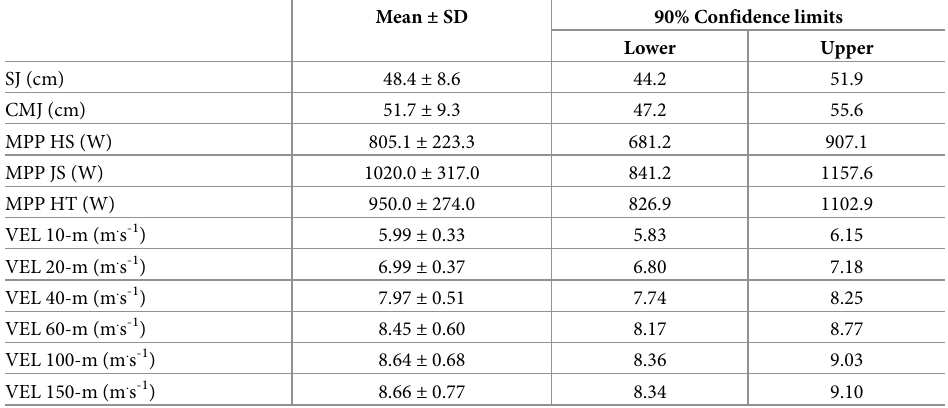
Table 1. Mean ± standard deviation (SD) of the vertical jumps, maximum mean propulsive power (MPP) in the different exercises, and sprinting velocities for the different distances tested in top-level sprinters and